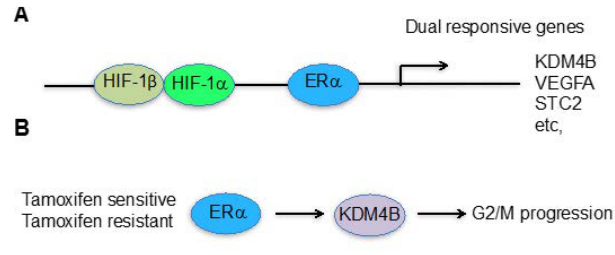
Figure 2. Hypoxia and estrogen pathways converge at KDM4B for cancer cell proliferation in ER α positive breast cancer. ( A ) KDM4B is one of the genes responsive to both estrogen and hypoxia-mediated pathways; ( B ) Regardless of endocrine therapy resistance, ER α drives KDM4B expression, which is required for G2/M phase